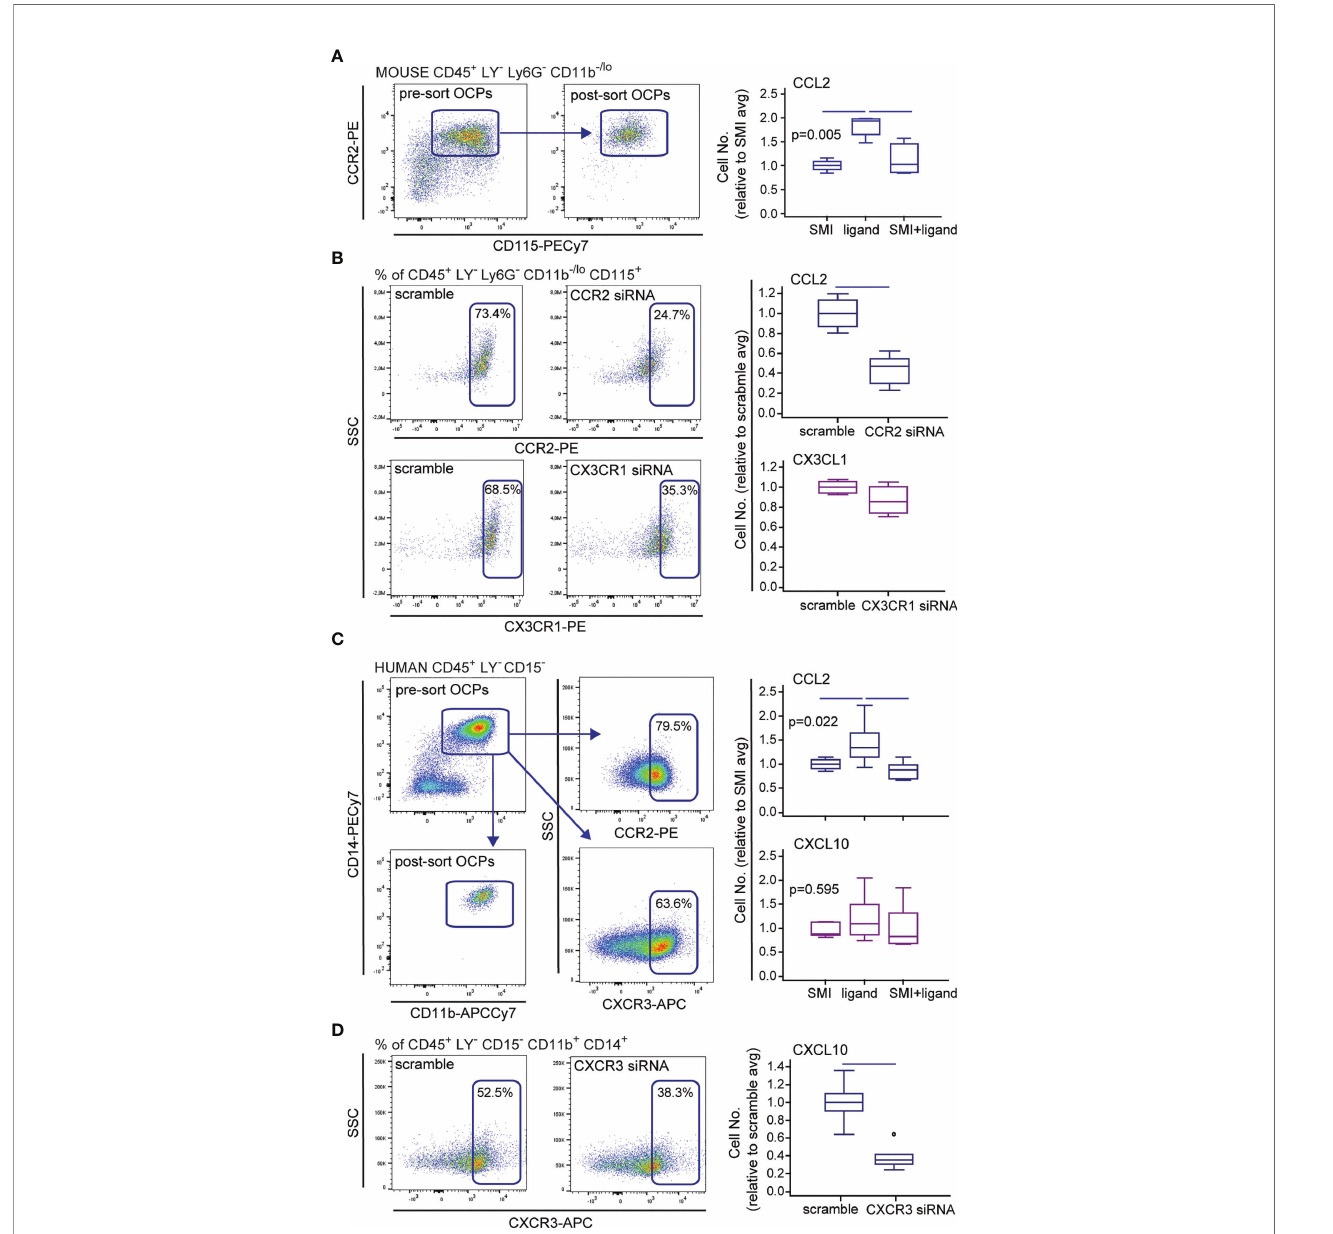
FIGURE 4 | Effect of small-molecule inhibitors (SMIs) and small interfering (si)RNA on migration of mouse and human osteoclast progenitors (OCPs) in vitro . Representative fl ow cytometry data of sorted population and chemokine receptor expression, and siRNA knockdown (CCR2 and CX3CR1 for mouse and CXCR3 for human cells) are shown on dot plots. (A) Sorted mouse periarticular bone marrow (PBM) OCPs bearing the phenotype CD45 + CD3 - B220 - NK1.1 - Ly6G - CD11b -/lo CD115 + from arthritic mice (CIA) were subjected to the in vitro migration assay toward the CCL2 gradient under the CCR2 SMI treatment, using the Transwell system. (B) Sorted mouse PBM OCPs bearing the phenotype CD45 + CD3 - B220 - NK1.1 - Ly6G - CD11b -/lo CD115 + from arthritic mice (CIA) were subjected to the in vitro migration assay toward the CCL2 and CX3CL1 gradient following CCR2 or CX3CR1 siRNA treatment, respectively, using the Transwell system. (C) Sorted human peripheral blood (PBL) OCPs bearing the phenotype CD45 + CD3 - CD19 - CD56 - CD11b + CD14 + from arthritic patients (RA) were subjected to the in vitro migration assay toward the CCL2 or CXCL10 gradient under the CCR2 or CXCR3 SMI treatment, respectively, using the Transwell system. (D) Sorted human PBL OCPs bearing the phenotype CD45 + CD3 - CD19 - CD56 - CD11b + CD14 + from RA patients were subjected to the in vitro migration assay toward the CXCL10 gradient following CXCR3 siRNA treatment, using the Transwell system. Cells migrated to the bottom membrane of the insert were stained with 4 ’ ,6-diamidino-2-phenylindole (DAPI) and counted. Values are normalized to the average value of control group (SMI or scramble avg), and presented as medians (middle horizontal lines), boxes represent the interquartile range (IQR), whiskers represent 1.5 times the IQR, and outliers are represented by circles. The experiments were repeated three times and pooled data are shown ( n = 6 – 8 Transwells per group). Statistically signi fi cant difference was determined at p < 0.05, Kruskal – Wallis test ( p -value marked on the graph) with Conover post-hoc test for group-to-group comparisons (A, C) , Mann – Whitney U -test (B, D) ; line denotes signi fi cant difference between groups. LY — CD3/B220/NK1.1 for mouse cells, CD3/CD19/CD56 for human